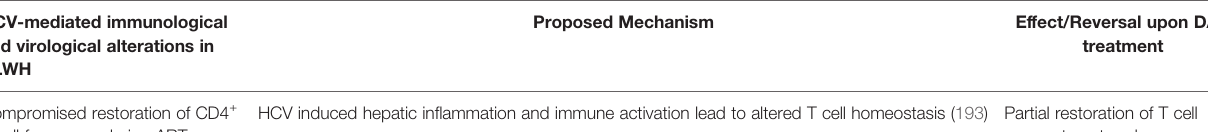
Augmentation of HIV